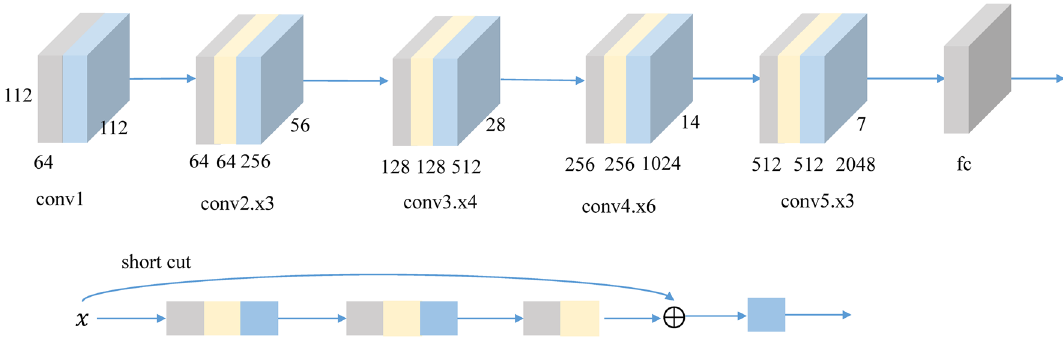
Figure 4. The network structure of the